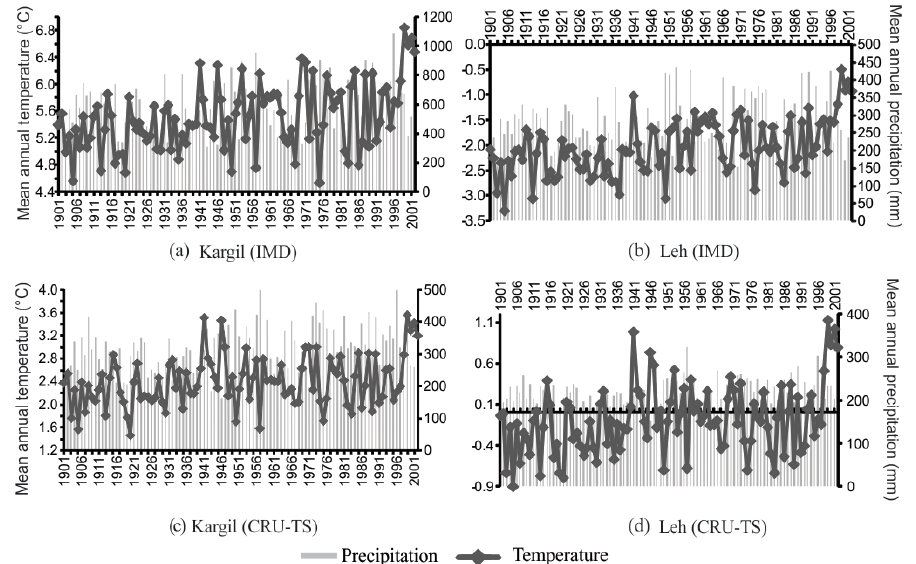
Figure 5. Analysis of meteorological (mean annual temperature and precipitation) datasets derived from the Indian Meteorological Depart- ment (IMD) stations at (a) Kargil and (b) Leh and the respective (c) Kargil and (d) Leh gridded data obtained from the Climate Research Unit (CRU) time series